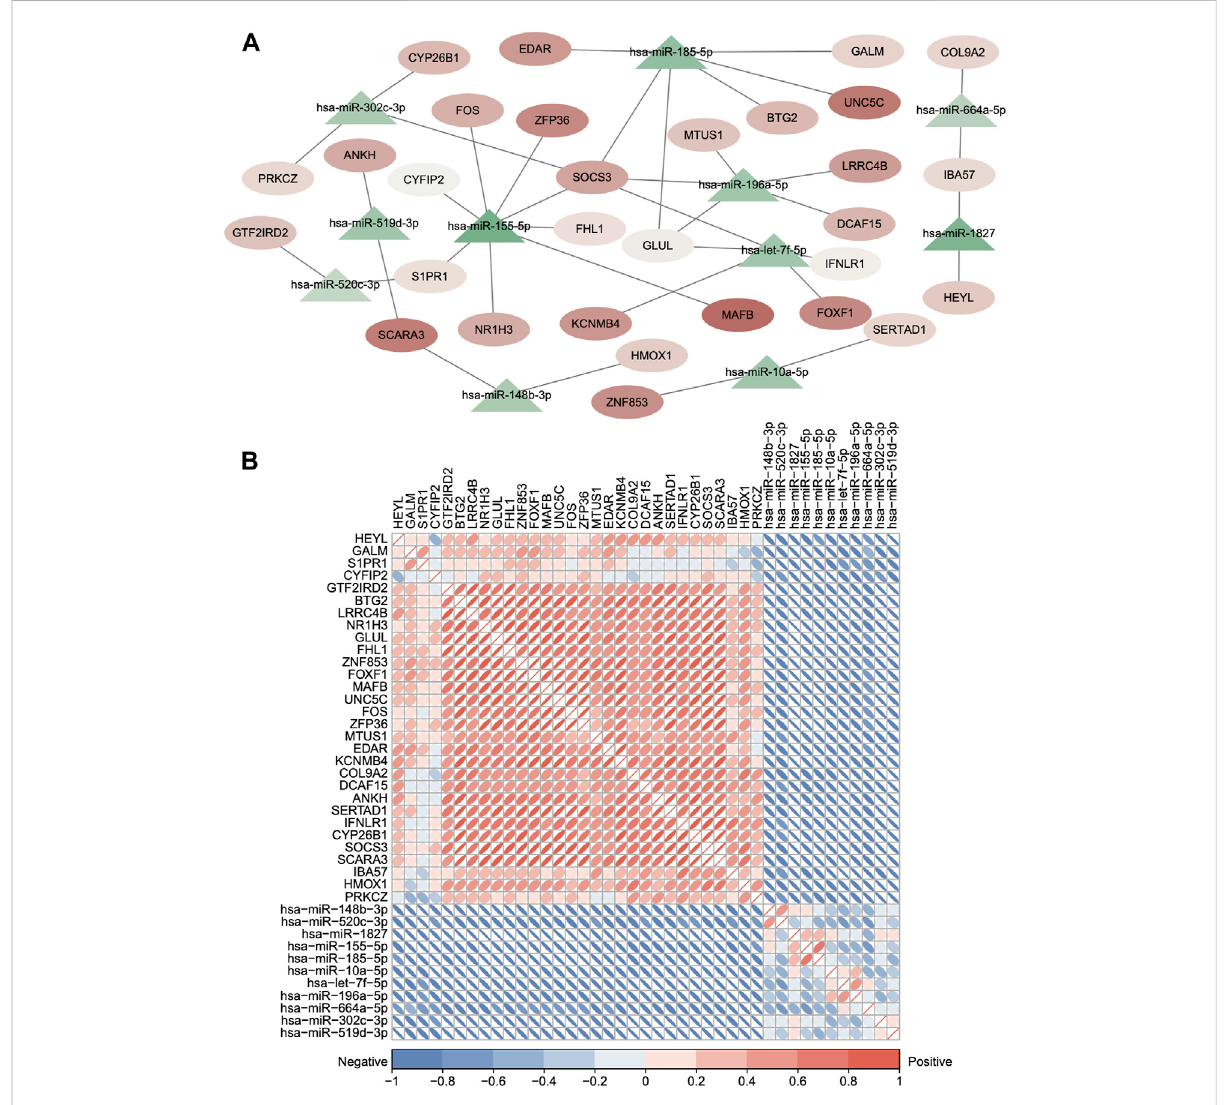
FIGURE 5 Dysregulated ceRNA between mRNAs and miRNAs in IDD. (A) Dysregulated ceRNA network between miRNAs and differentially expressed mRNAs. (hypergeometric test p < 0.05 and Pearson test p < 0.05). Red represents upregulated, and blue represents downregulated. The triangle nodes represent DEGs, and ellipse nodes represent miRNAs; the color gradient indicates the difference in expression. (B) Clustered corrplot of miRNAs and differentially expressed mRNAs in the ceRNA network. The color gradient represents the expression correlation score between